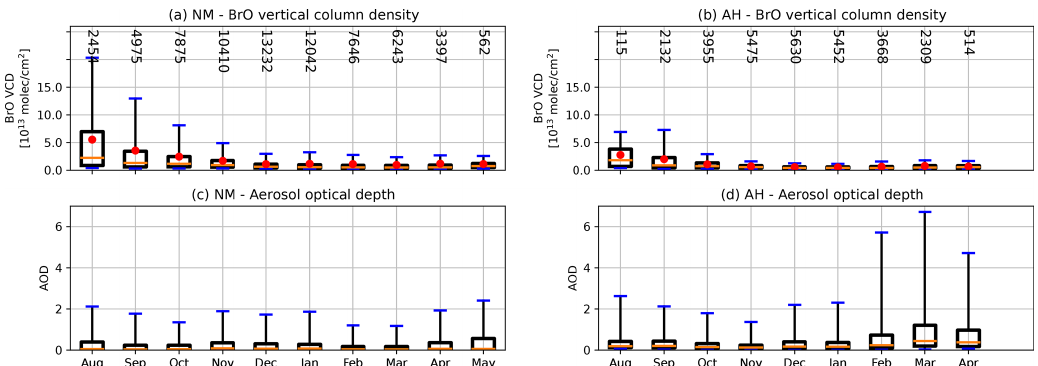
Figure 7. Box-and-whisker plots of the seasonal variation in the BrO VCD (a, b) and AOD (c, d) for NM (a, c) and AH (b, d) based on all available data. Here (and in all following box and whisker plots), boxes indicate the 25th–75th percentile and whiskers the 9th–95th percentile. Mean and median are shown as red dots and vertical orange lines, respectively. The numbers denote the data count in each.